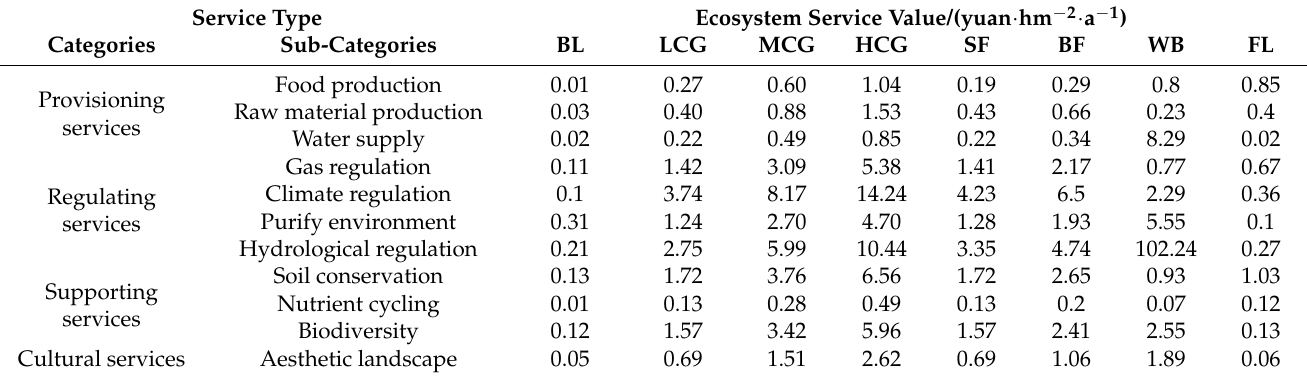
Table 1. Ecosystem Service Values per unit area in different Chinese land